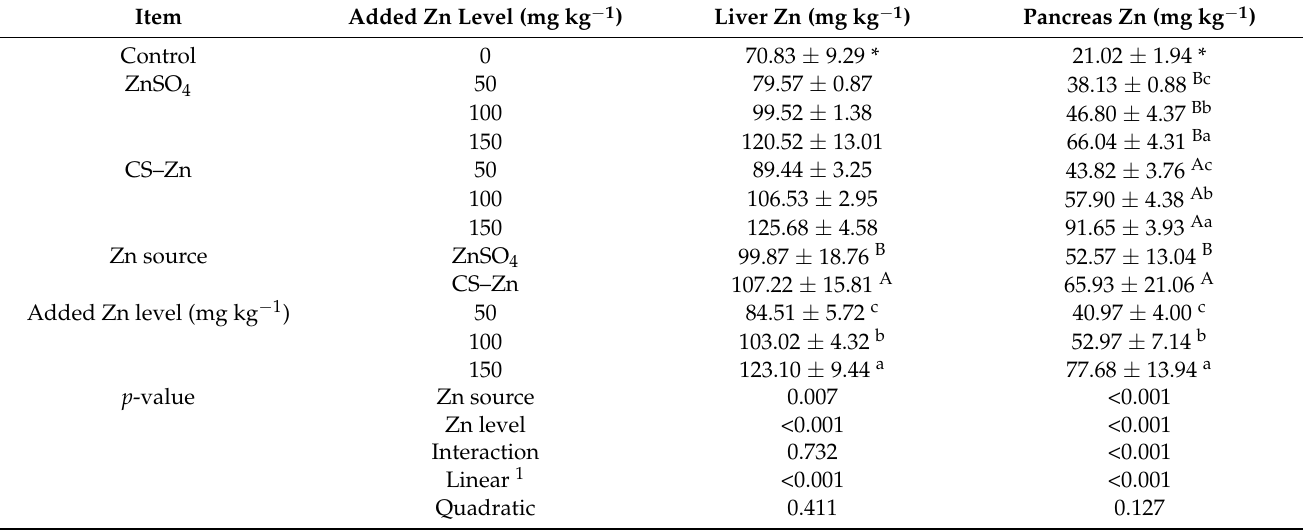
Table 3. Effects of dietary Zn source and level on the content of Zn in the liver and pancreas of weaned